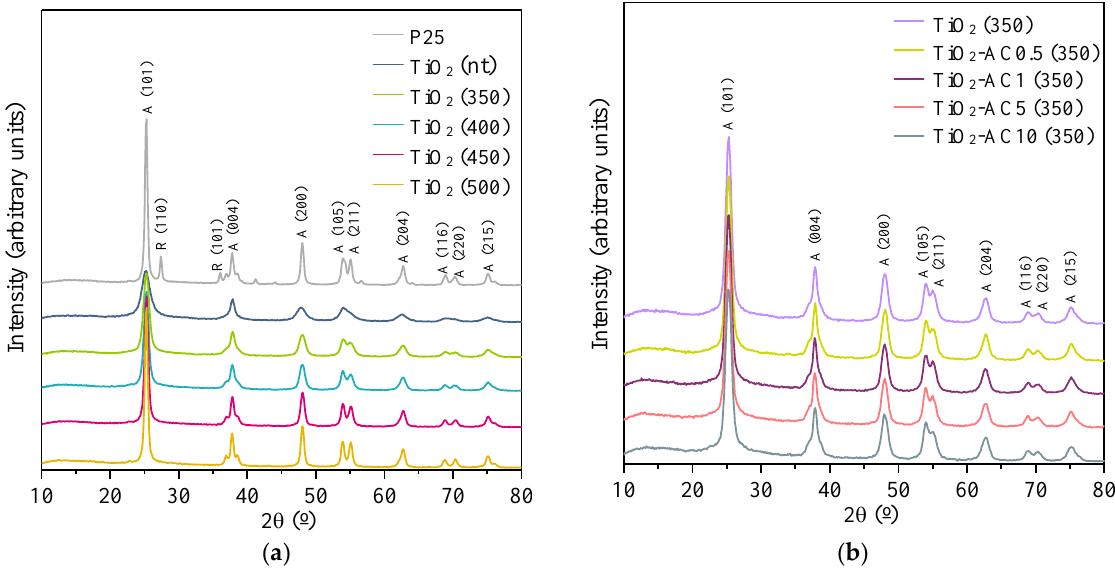
Figure 2. XRD patterns for: ( a ) P25, TiO 2 (nt) and TiO 2 (T) samples, and ( b ) AC, TiO 2 -ACx (350) (x = 0, 0.5, 1, 5, and 10 wt.%) samples. The 2 θ values of the TiO 2 characteristic diffraction peaks are: Anatase (A) (ref. JCPDS No. 21-1272): 25.3 ◦ (101), 37.8 ◦ (004), 48.0 ◦ (200), 54.5 ◦ (105), 55 ◦ (211), 62.7 ◦ (204), 70.4 ◦ (116) and 74.5 ◦ (220); and Rutile (R) (ref. JCPDS No. 21-1276): 27.5 ◦ (110), 36.1 ◦ (101) and 54.4 ◦